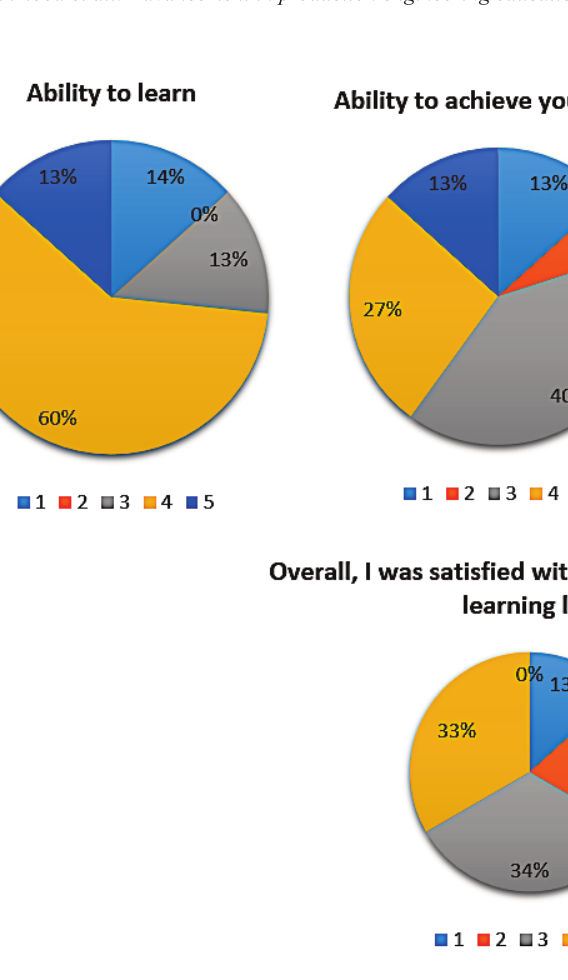
Fig. 10. Graphical representation of students’ feedback about the online (3rd)